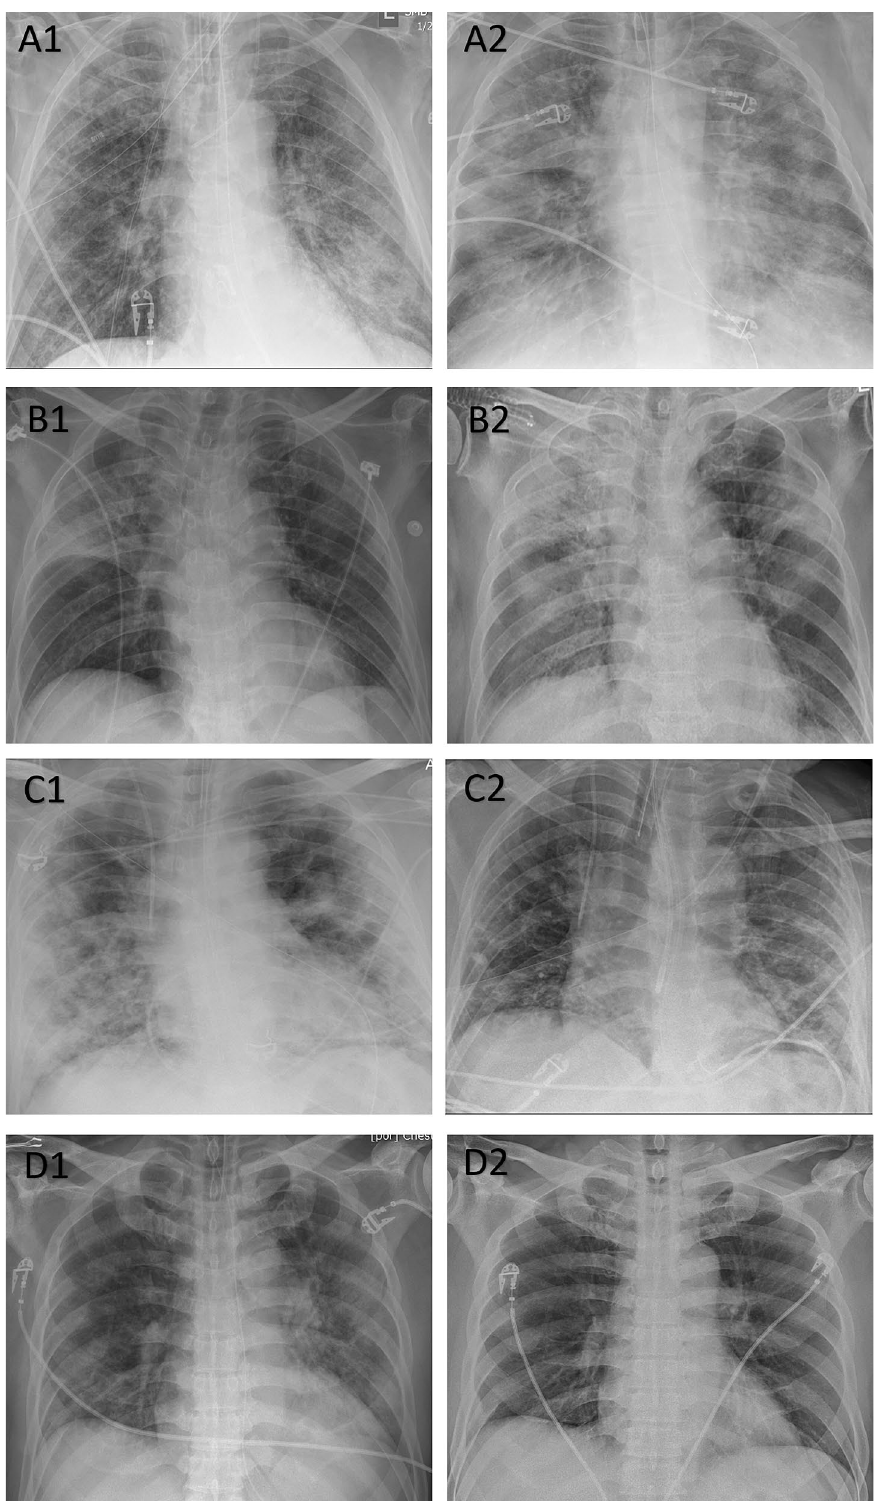
Figure 1. Frontal CXRs of patients with RT-PCR positive COVID-19 pneumonia. A A 65-year-old male from Site A with baseline (A1: RALE score 12, AI score 101) and follow-up CXRs (A2: RALE score 32, AI score 175) received mechanical ventilation and died after 30 days of hospitalization. B An 84-year-old male from Site B with baseline (B1: RALE score 10, AI score 59) and follow-up CXRs (B2: RALE score of 29, AI score 127) received mechanical ventilation and expired after 17 days of hospitalization. C A 58-year-old male from Site A had full recovery following hospitalization (baseline CXR, C1: RALE score 24, AI score 156; follow-up CXR, C2: RALE score 9, AI score 133). The patient required mechanical ventilation. D A 57-year-old male from Site B had full recovery following hospitalization. The radiographic opacities on baseline CXR (D1: RALE score 11, AI score 98) resolved on follow-up CXR (D2: RALE score 0, AI score 0). The patient did not require mechanical